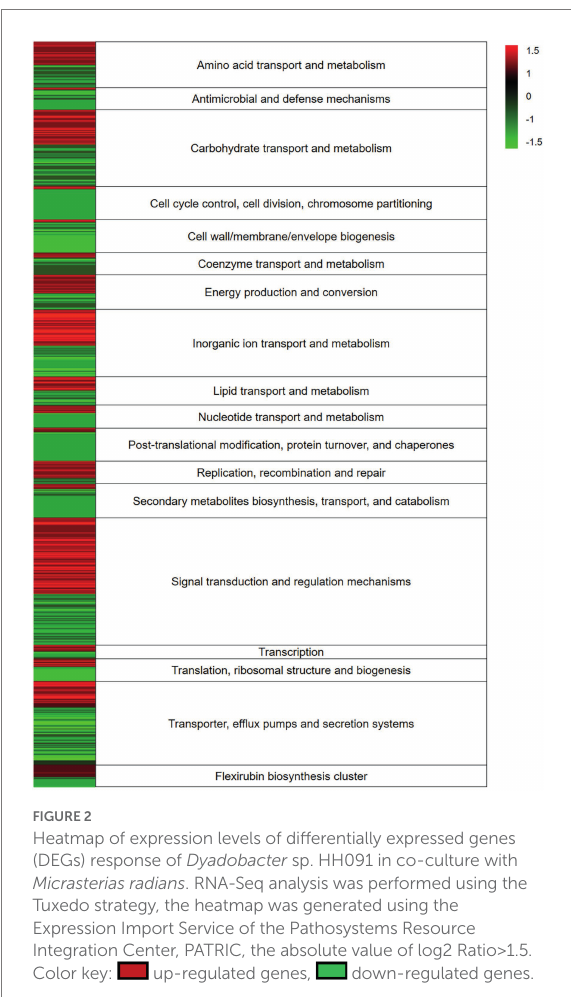
FIGURE 2 Heatmap of expression levels of differentially expressed genes (DEGs) response of Dyadobacter sp. HH091 in co-culture with Micrasterias radians . RNA-Seq analysis was performed using the Tuxedo strategy, the heatmap was generated using the Expression Import Service of the Pathosystems Resource Integration Center, PATRIC, the absolute value of log2 Ratio > 1.5. Color